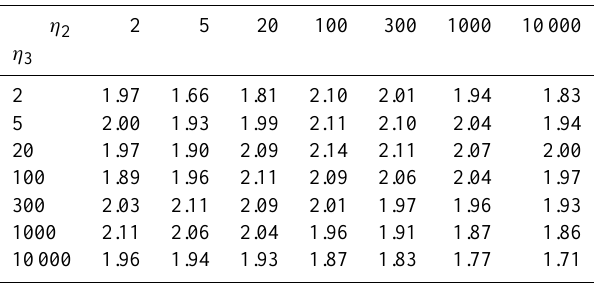
Table A6. Tangent of the slope of the curve showing the dependence of the logarithm of L 2 -error for velocity component v y on the loga- rithm of the grid step for different viscosity contrasts. Exponentially varying